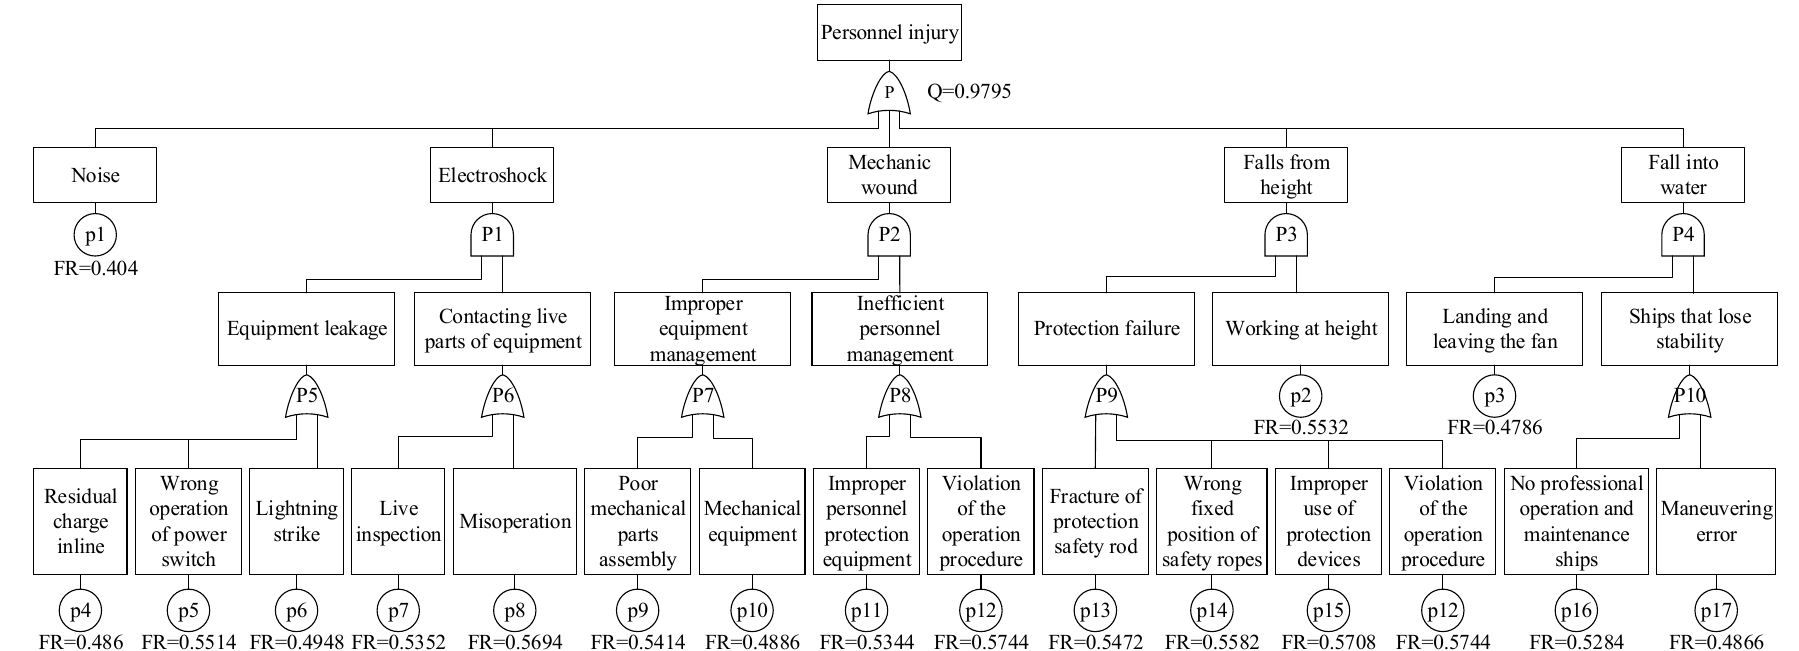
Figure 9. Fault tree analysis model for personnel injury risk of the offshore wind farm.